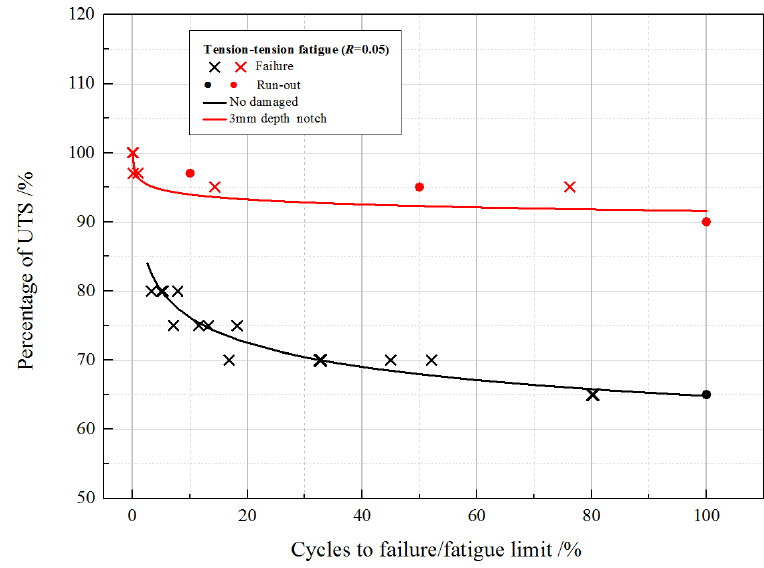
Figure 8: Normalized fatigue data for no-damaged, 3mm depth of double-edge notched